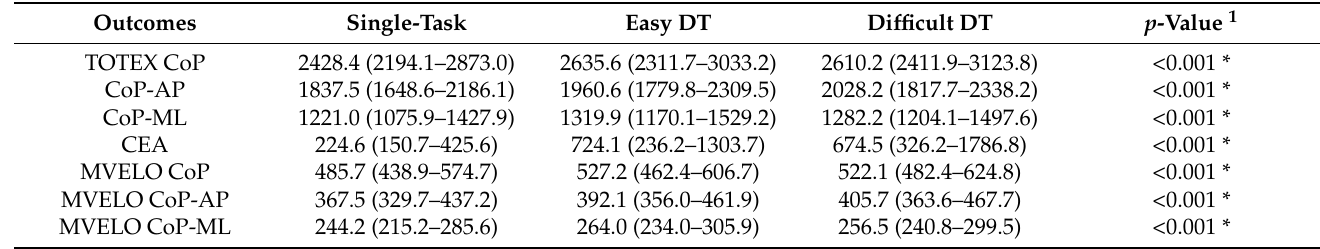
Table 2. Comparisons of CoP behavior among the postural task (ST), easy and difficult dual-task, median (IQR).